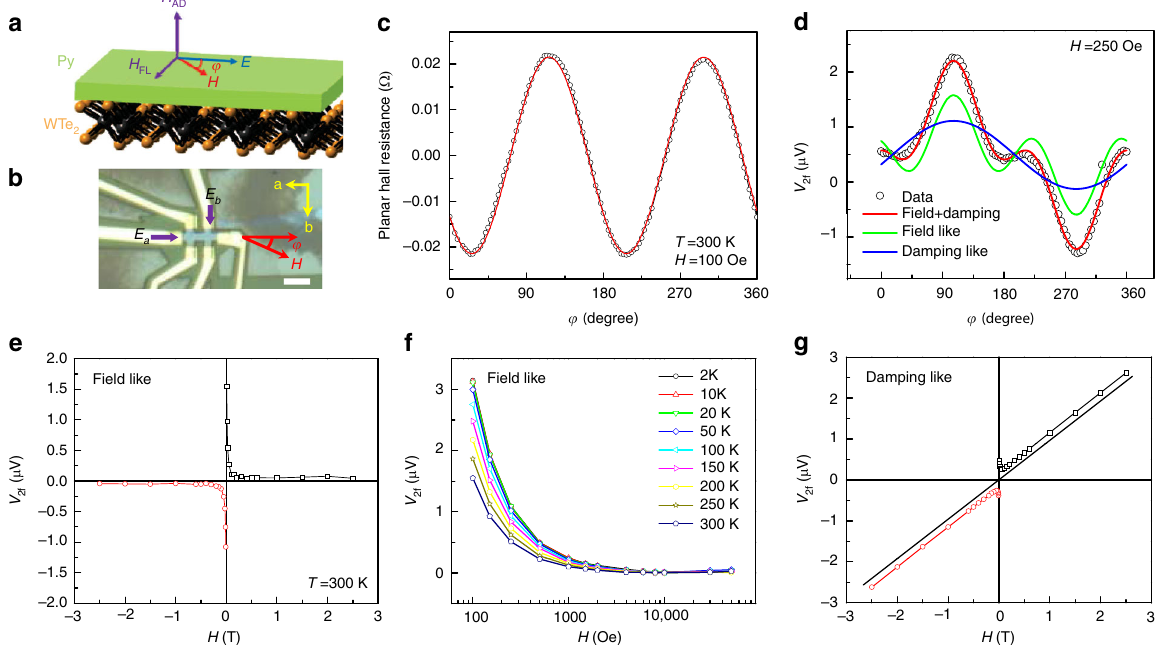
Fig. 4 Second-harmonic Hall measurement of spin – orbit torques in WTe 2 /Py. a A schematic of the spin orbit torque in WTe 2 /Py devices under an electric fi eld ( E ) with an in-plane magnetization ( M ). The effective fi elds of the FL torque and DL torque are also presented. b An optical image of the Hall bar device for the second-harmonic Hall voltage ( V 2 f ) measurement. The AC electrical fi elds along the various in-plane crystalline axes are indicated. The white scale bar is 10 μ m. c The typical planar Hall resistance as a function of the azimuthal angle of the magnetic fi eld. d The typical angular-dependent V 2 f ( T = 300 K, H = 250 Oe) and the fi tted data for both the FL and DL torques. e The typical extracted symmetric second-harmonic voltage produced by the FL torque as a function of the magnetic fi eld. f The dependence of V 2 f extracted for the FL torque on the applied magnetic fi eld and temperature. g The dependence of V 2 f extracted for the DL torque on the applied magnetic fi